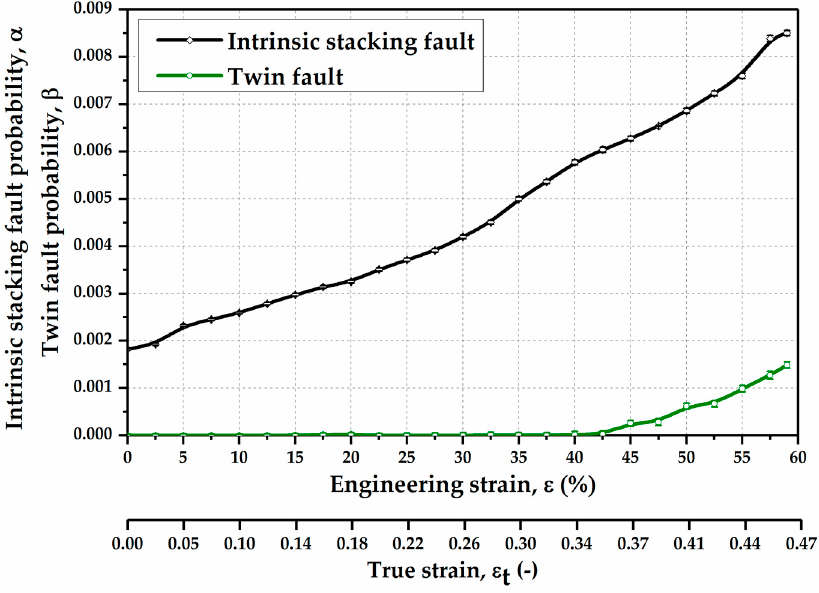
Figure 7. Intrinsic stacking fault probability and twin fault probability as a function of strain in the Fe-17Mn-1.5Al-0.3C steel measured by SYXRD.